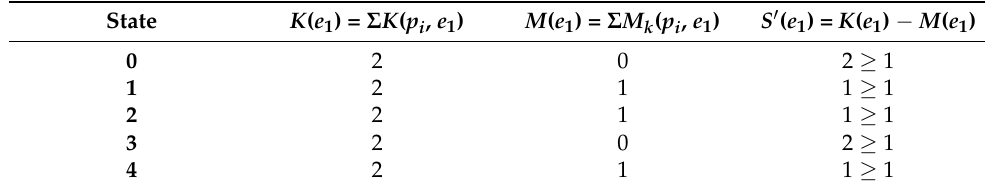
Figure 10. Reachability states of the CROPN presented in Figure 9. Table 1. The free spaces in an e 1 .